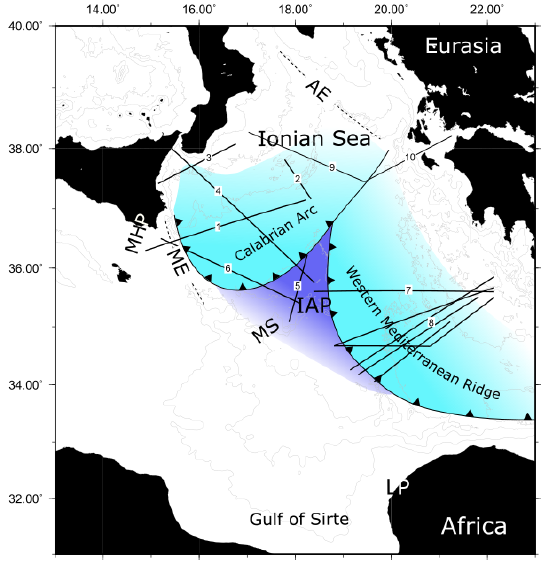
Figure 8. Dark blue marks the presence of oceanic lithosphere be- low the sea floor in the Ionian Abyssal Plain (undeformed portion) as determined by seismic studies. Light blue areas mark the extent of buried oceanic lithosphere below adjacent accretionary wedges as determined by seismic studies. Profiles 1–5: M111; profile 6: Makris et al. (1986) and Finetti (2003) (part of CROP M23A); pro- files 7–8: IMERSE profiles (Fruehn et al., 2001; Westbrook and Re- ston, 2002; Reston et al., 2002); profiles 9 and 10: ION6 (Cernobori et al., 1996) and ION7 (Kokinou et al., 2003). AE – Apulian Es- carpment. Further abbreviations are explained in Fig.